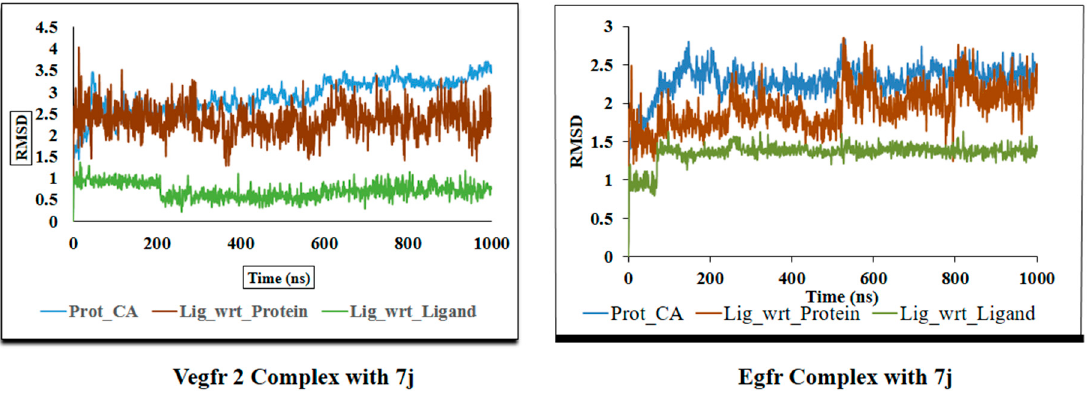
Figure 9. Root mean square deviation (RMSD) of the C-alpha atoms of 7j-VEGFR 2 Complex and 7j-EGFR complex with time. 7j-EGFR complex with